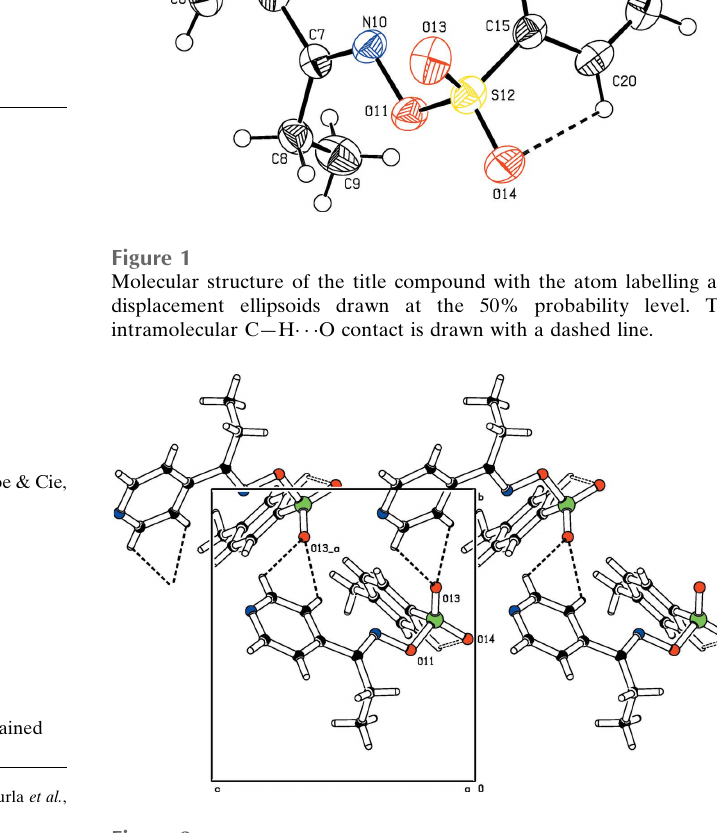
Figure 2 Partial packing diagram viewed along the a axis. Intramolecular